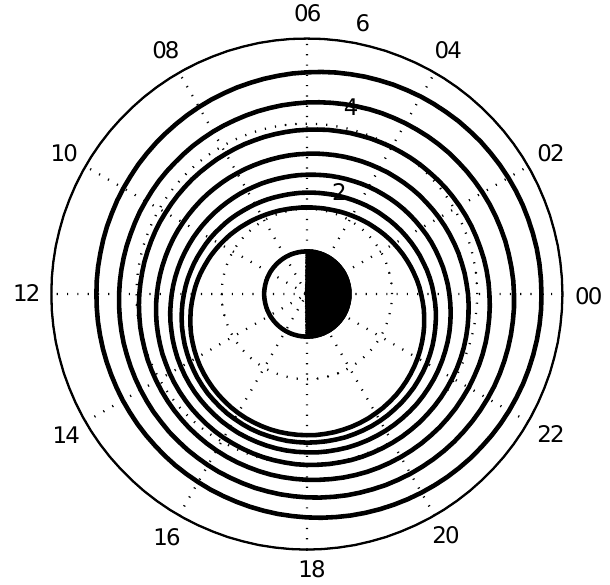
Fig. 11. Average shape of the PPCH-2012 plasmapause position in L -value space for Kp=0.5, 1.5, ... 6.5.